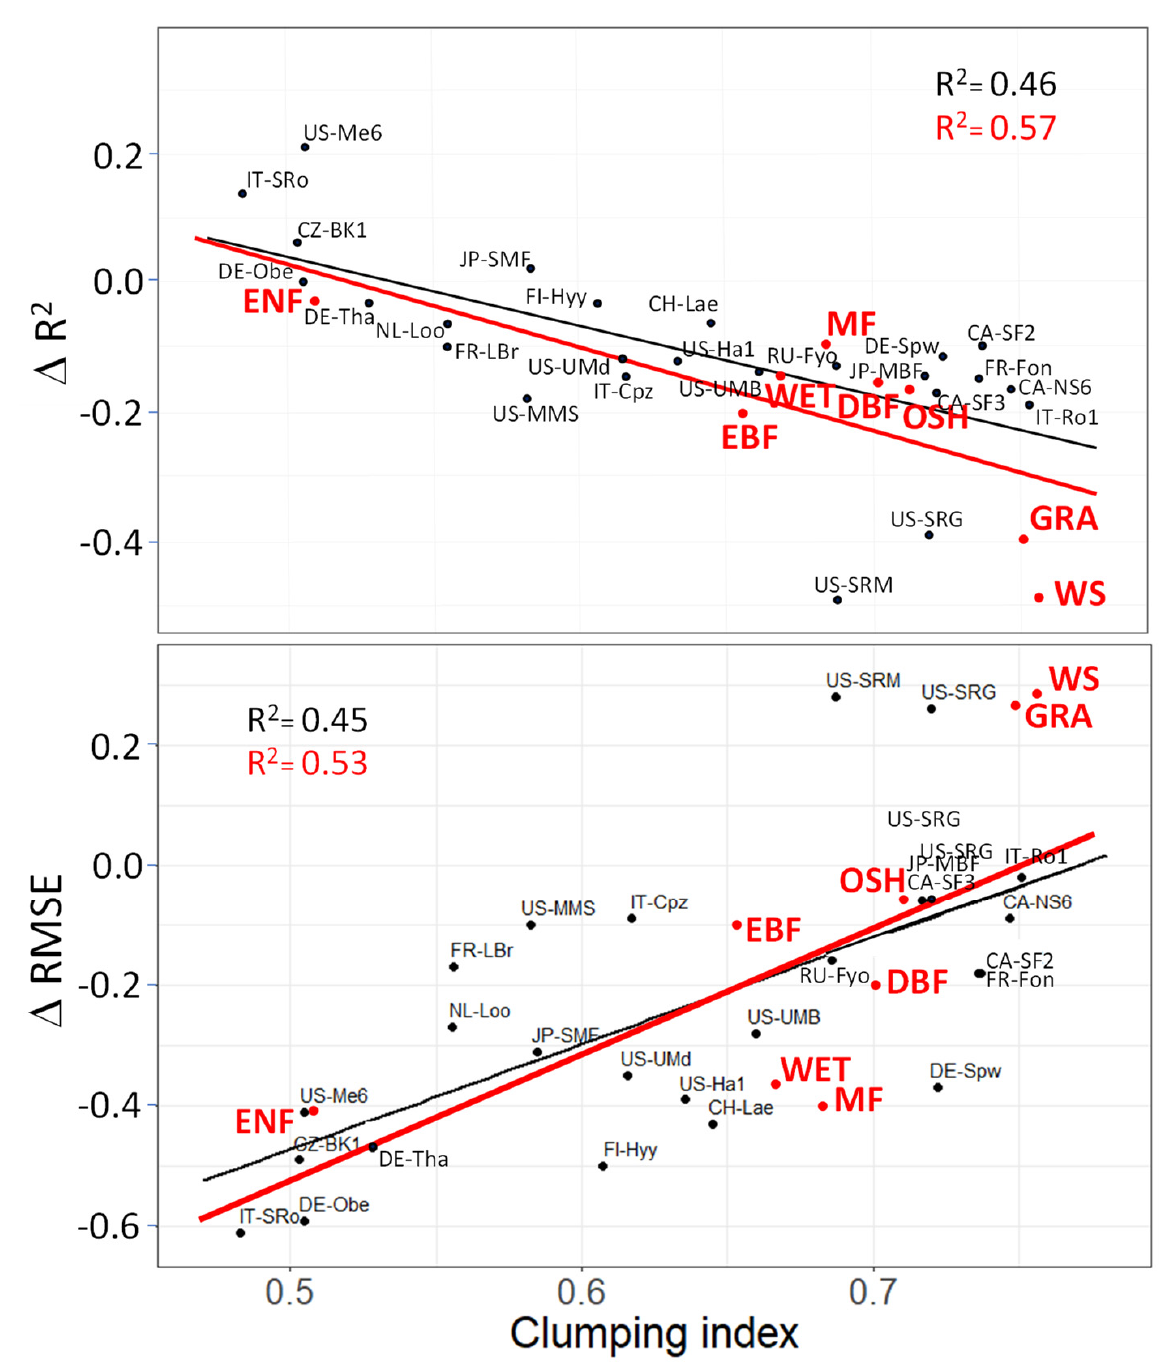
Figure 3. Relationship between the clumping index and the variation in R 2 ( ∆ R 2 ) and RMSE ( ∆ RMSE) between the ground-measured GPP and the satellite-estimated GPP after adding PPFD information to the NIRv model (GPPnirppfd vs. GPPnirv) in black for the different studied sites (Table 1) (CI calculated as the average annual value per site from the CI product LIS-CI-A1), and in red for the different vegetation cover types (CI for vegetation cover type as in He et al. [24]): evergreen needleleaf forest (ENF), evergreen broadleaf forest (EBF), deciduous broadleaf forest (DBF), mixed forest (MF), open shrubland (OSH), grassland (GRA), woody savanna (WSA) and wetland